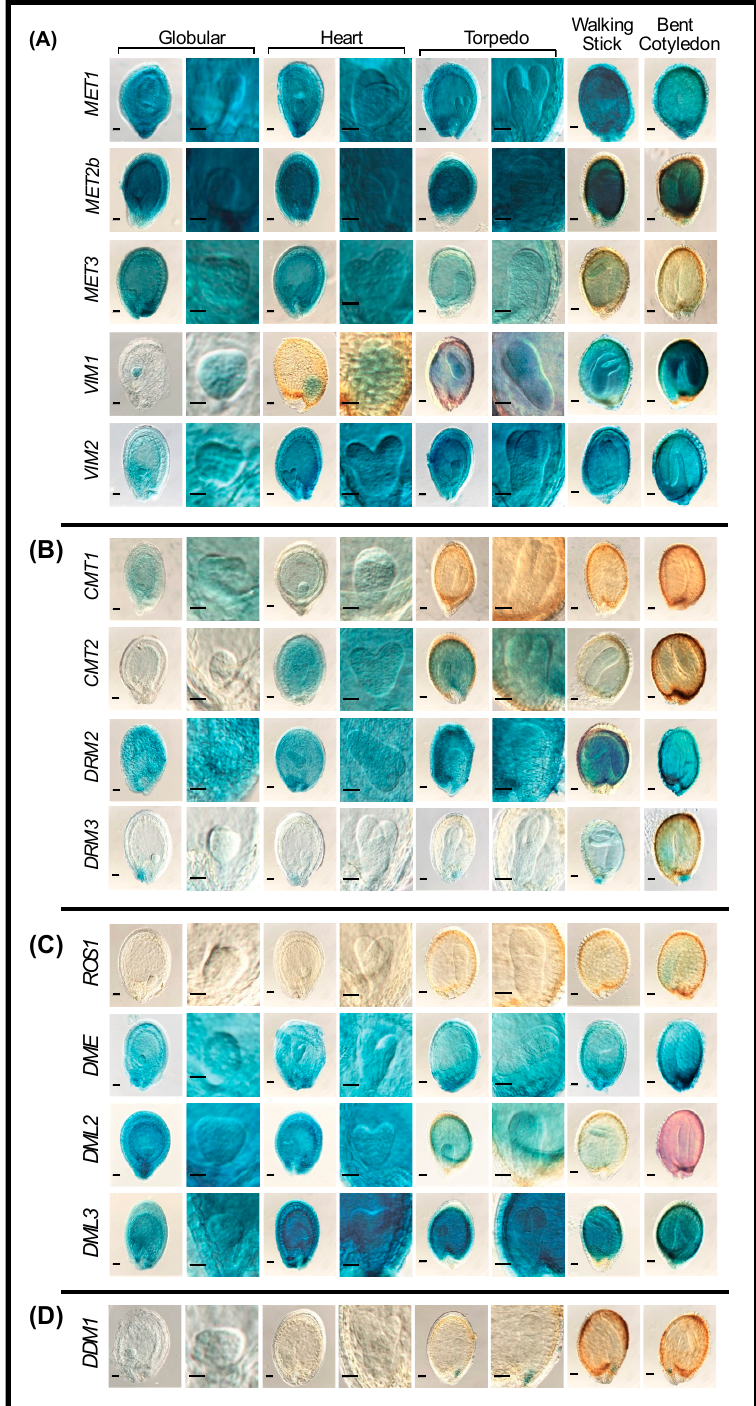
Figure 4. Promoter activity of DNA methylation and demethylation-related genes during various stages of seed development. A–C: Histochemical localization of GUS activity directed by promoters of the CG methylation-related genes MET1 , MET2b , MET3 , VIM1 , and VIM2 ( A ), the non-CG and RdDM-related methyltransferases CMT1 , CMT2 , DRM2 , and DRM3 ( B ), the demethylases ROS1, DME , DML2 , and DML3 ( C ), and DDM1 ( D ) at globular, heart, torpedo, walking-stick, and bent- cotyledon embryo stages. Scale bar = 5 mm.